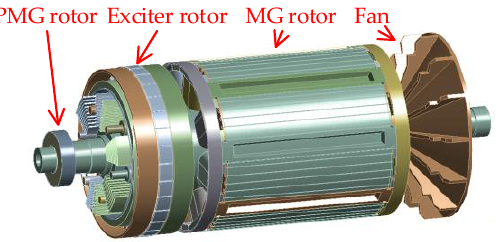
Figure 13. Generator rotor structure model.